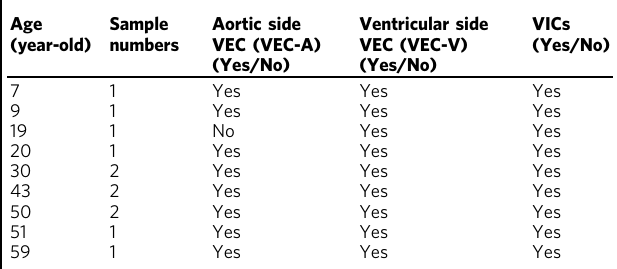
used as controls. An average of 16,000 genes in the primary hVECs were identi fi ed, which was similar to that of HUVEC (Supplementary Fig. 4a). Heat map analysis of normalized RNA- seq data showed that day 7 hPSC-derived VELs were globally more similar to the primary VECs than HUVEC and HAEC (Supplementary Fig. 4b). When the heap map analysis was per- formed using a subset of G2 genes, a similar result was obtained (Supplementary Fig. 4c). We con fi rmed this by qRT-PCR analysis (Supplementary Fig. 4d, e).